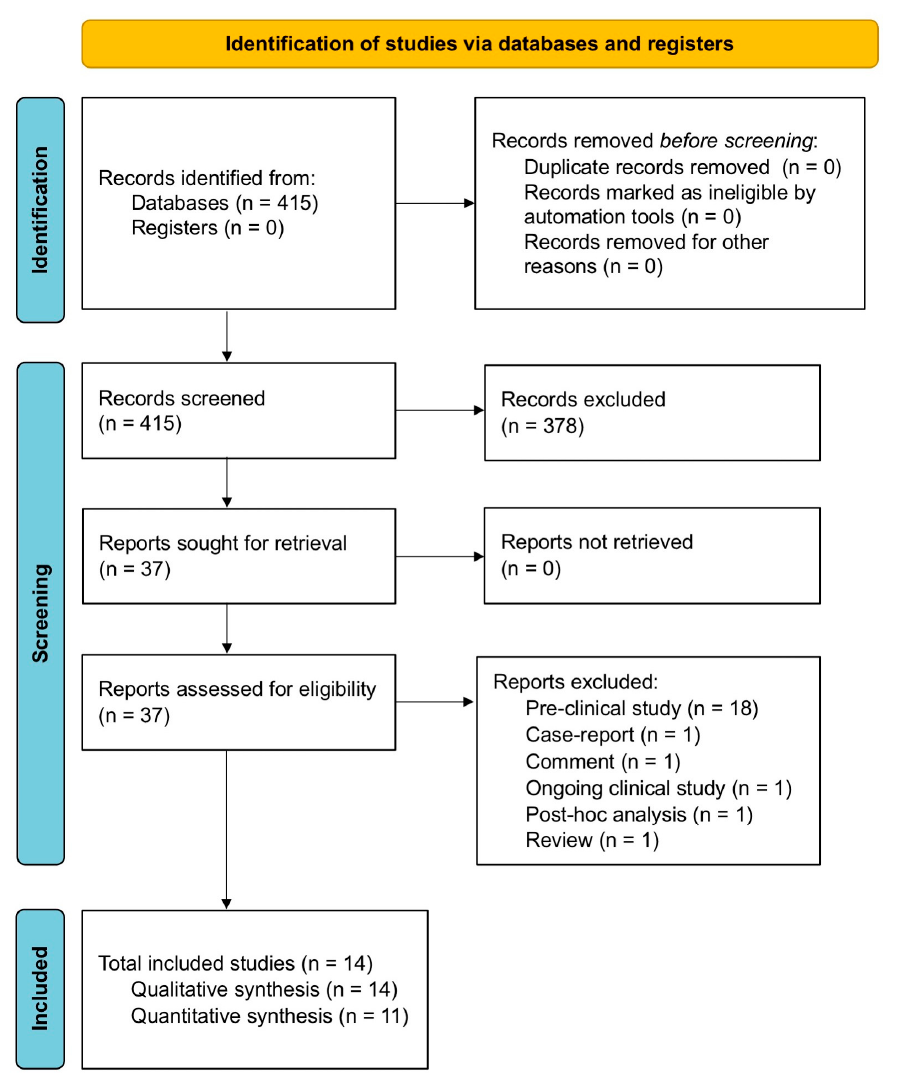
Figure 1. PRISMA 2020 flow diagram for the identification of the clinical studies included in the qualitative and quantitative synthesis. PRISMA: Preferred Reporting Items for Systematic Reviews and